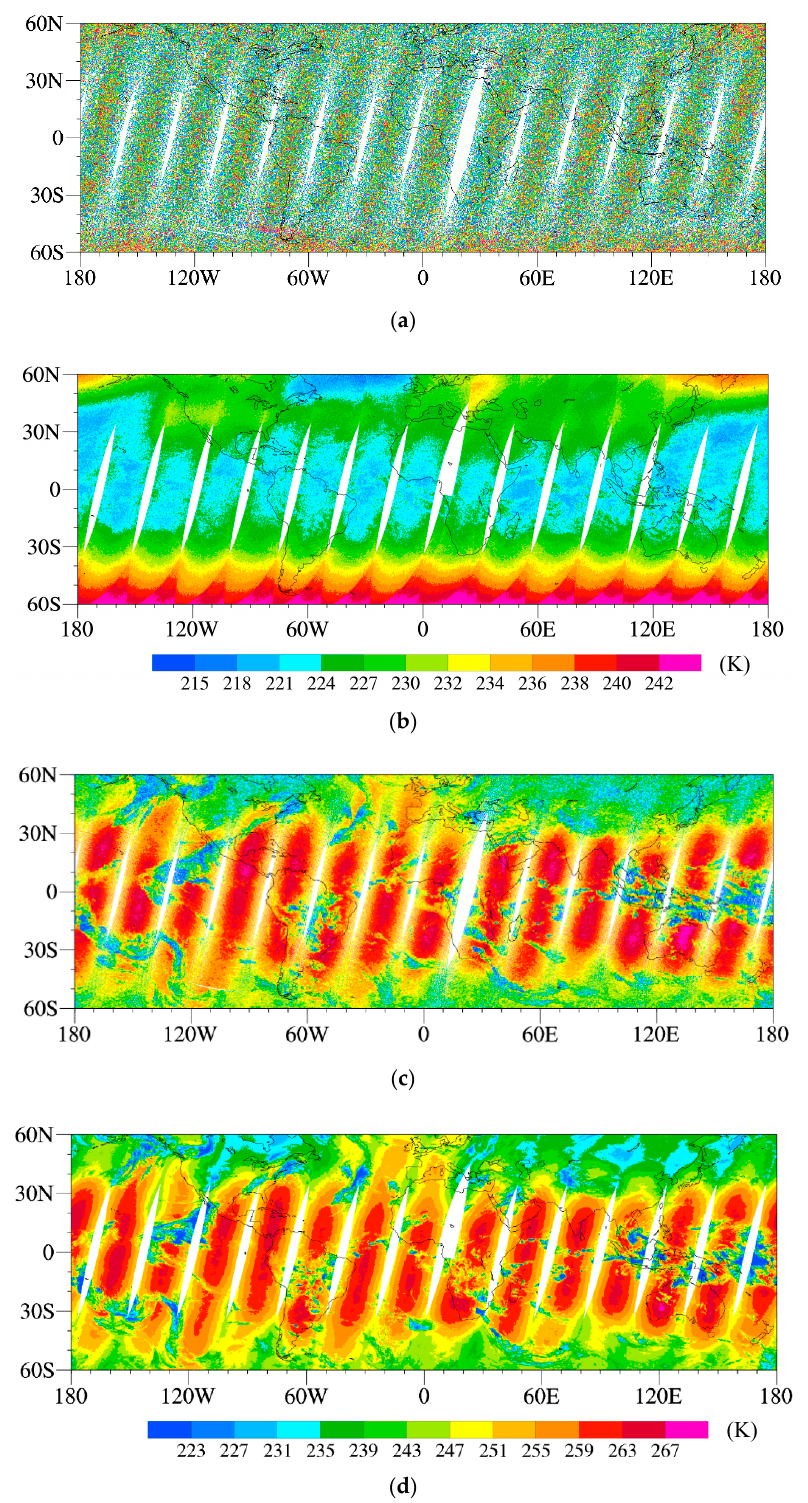
Figure 2. Spatial distributions of brightness temperature observations (unit: K) of ( a ) HIRAS SWIR channel 2007 (2382.5 cm − 1 , peak WF at 133 hPa), ( b ) CrIS SWIR channel 1238 (2382.5 cm − 1 , peak WF at 133 hPa), ( c ) HIRAS SWIR channel 1759 (2227.5 cm − 1 , peak WF at 535 hPa), and ( d ) CrIS SWIR channel 1176 (2227.5 cm − 1 , peak WF at 535 hPa) at descending nodes on 1 January